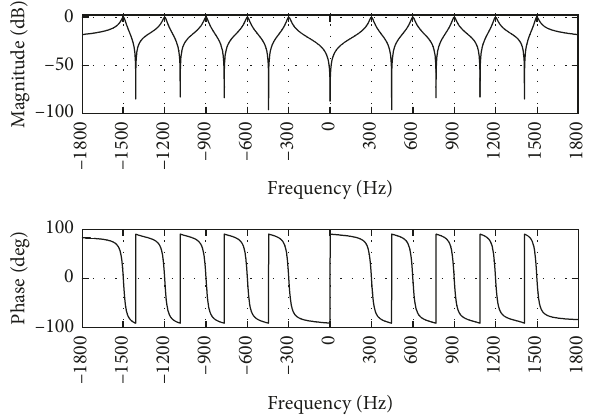
Figure 2: Bode diagram of VR